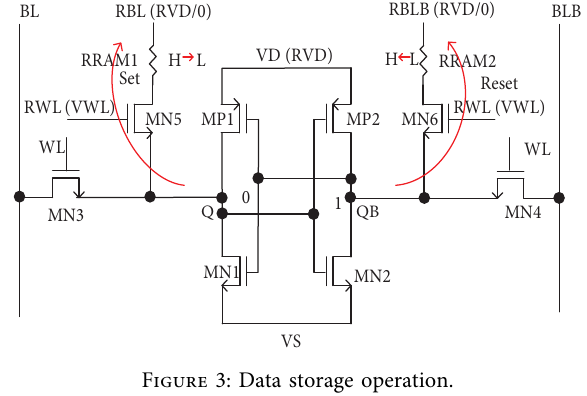
Figure 3: Data storage